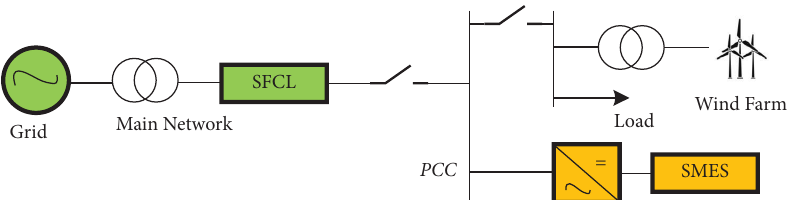
Figure 15: Te integration of WS to grid with the support of SFCL+SMES.